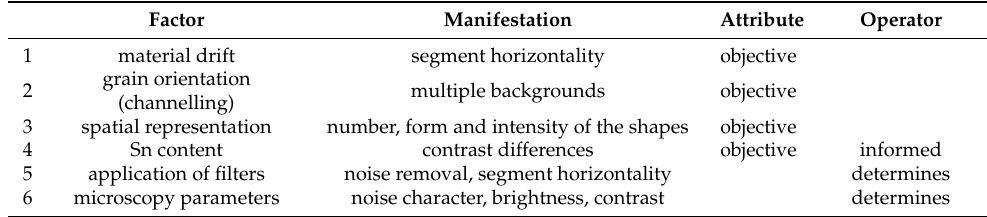
Table 10. Factors affecting the BG/LD(Shapes) and L/D histograms.